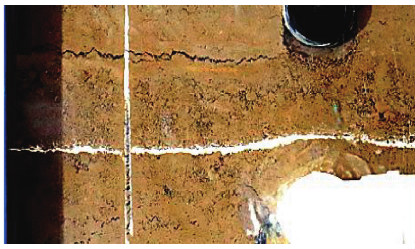
Figure 10: The transverse tensile crack. Table 3: Experiment 4 and 5 cavity parameter table.